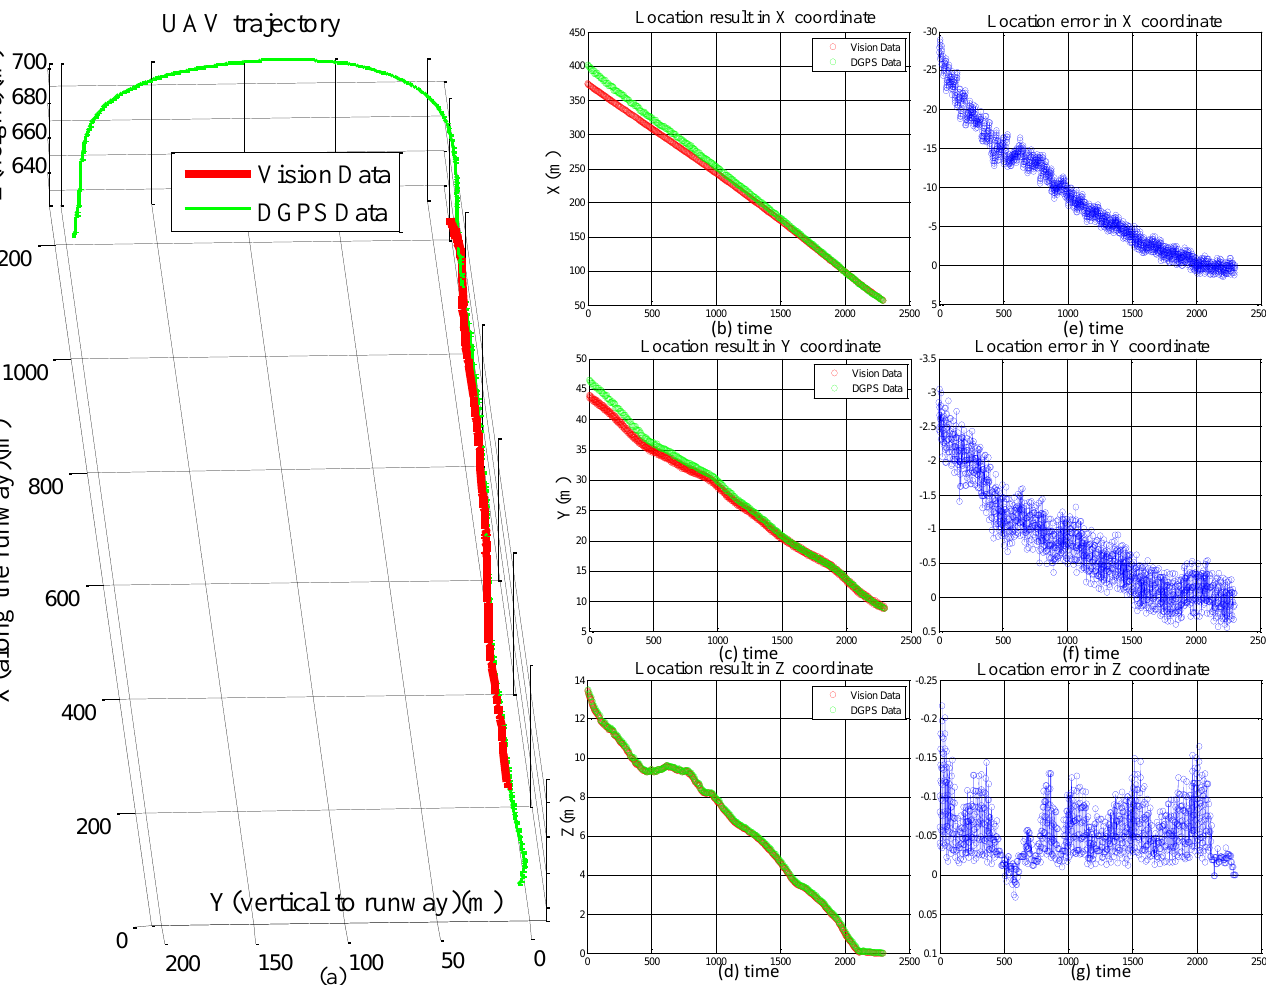
Figure 10. Comparison of DGPS and vision data. ( a ) The UAV trajectories of vision-based method and DGPS method; ( b – d ) The location results in X , Y and Z coordinates. ( e – g ) The location errors in X , Y and Z